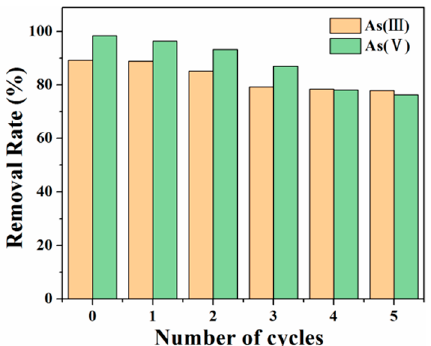
Figure 14. Recycling performance of different Fe 3 O 4 @SFBC materials (pH = 6 and 4, dose=1 g/L, initial concentration=5 mg/L, T=25°C).